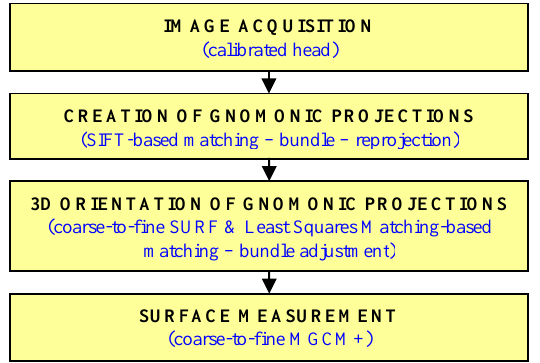
Fig. 1. The flowchart for images acquisition and 3D reconstruction from gnomonic projections.